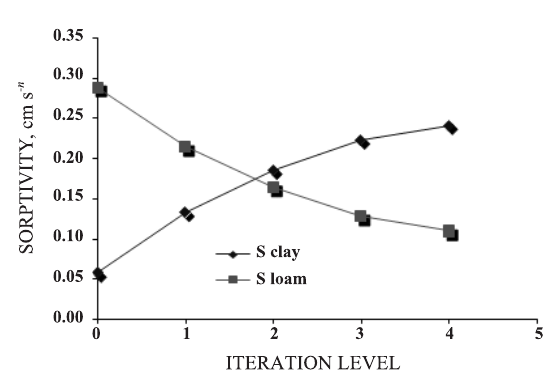
Figure 8. Sorptivity parameter estimated with the time exponent also estimated by regression at each iteration level for clay and loam